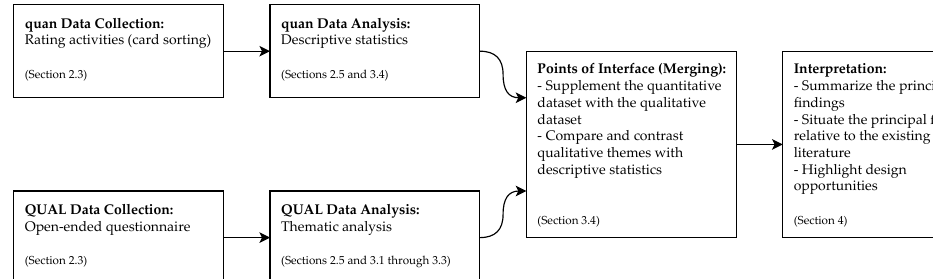
Figure 1. Diagram of the convergent design of the study presented herein, following the notation system for drawing diagrams of design [11]. The quantitative data collection and analysis appear at the top of the figure, while the qualitative aspects appear at the bottom. We implemented the quantitative and qualitative strands simultaneously but placed greater emphasis on the latter within the study, as indicated by using lowercase (“quan”) and uppercase (“QUAL”) letters. The figure also shows the merging of the two strands and the overall